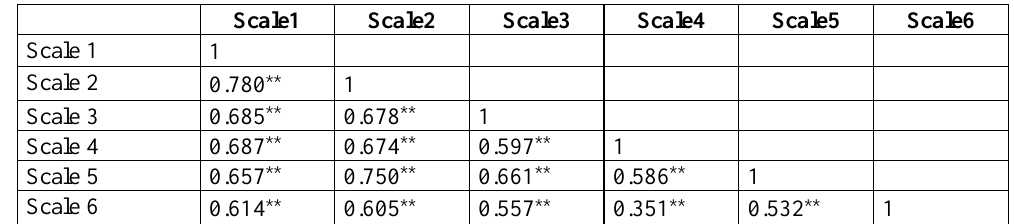
Table 3. Relationships between Different Scales from the Competence